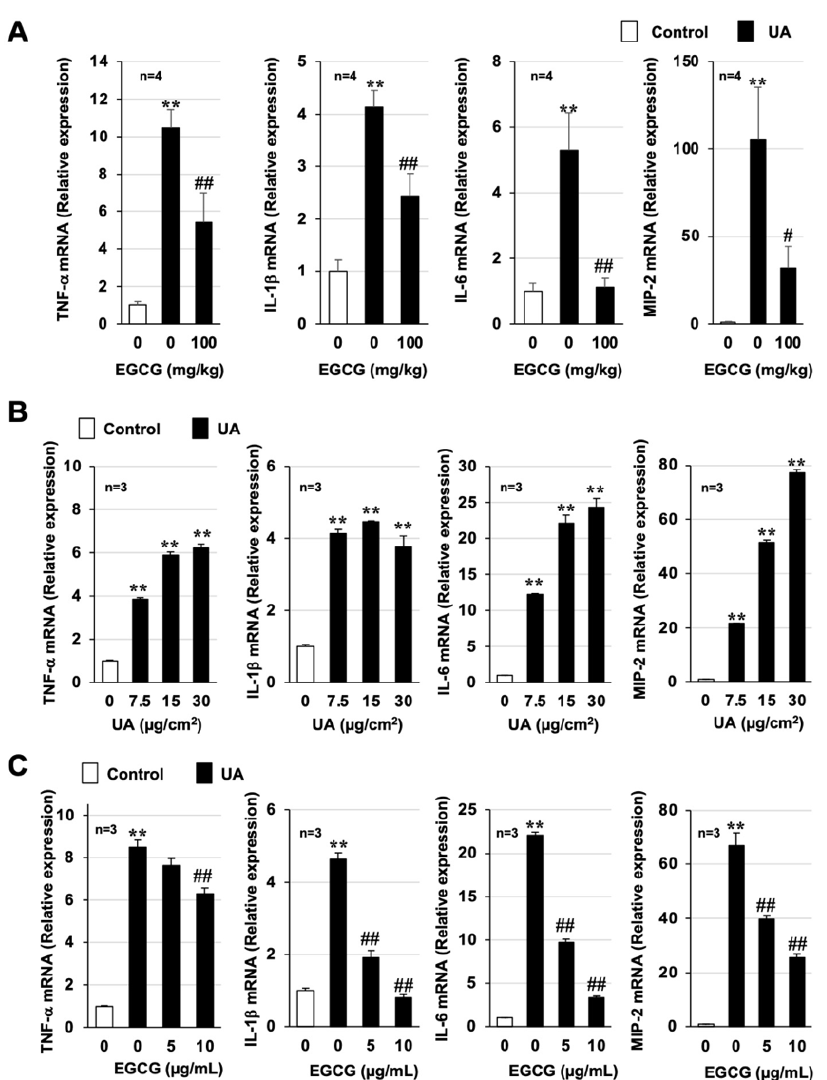
Figure 3. Effect of EGCG on urban aerosol-dependent inflammatory responses . ( A ) Male ICR mice were intraperitoneally administered EGCG (100 mg/kg in sterile saline) or sterile saline 1 h before intratracheal administration of urban aerosol particle suspension (1.0 mg/mouse) or sterile saline (Control). Total RNA was extracted from the lungs 24 h after urban aerosol particle suspension administration and subjected to real-time RT-PCR using a specific primer set for each gene. Values were normalized to Gapdh and are expressed relative to the control. ( B , C ) RAW264 cells were treated with urban aerosols (7.5–30 µ g/cm 2 ) ( B ) or EGCG (5–10 µ g/mL) prior to the addition of urban aerosols (30 µ g/cm 2 ) ( C ) to the medium. Total RNA was extracted from the RAW264 cells 24 h after the addition of urban aerosols and subjected to real-time RT-PCR using a specific primer set for each gene. Values were normalized to Gapdh and are expressed relative to the control. Values are expressed as the mean ± SEM; # p < 0.05; ** or ## p < 0.01. ( # vs. UA).